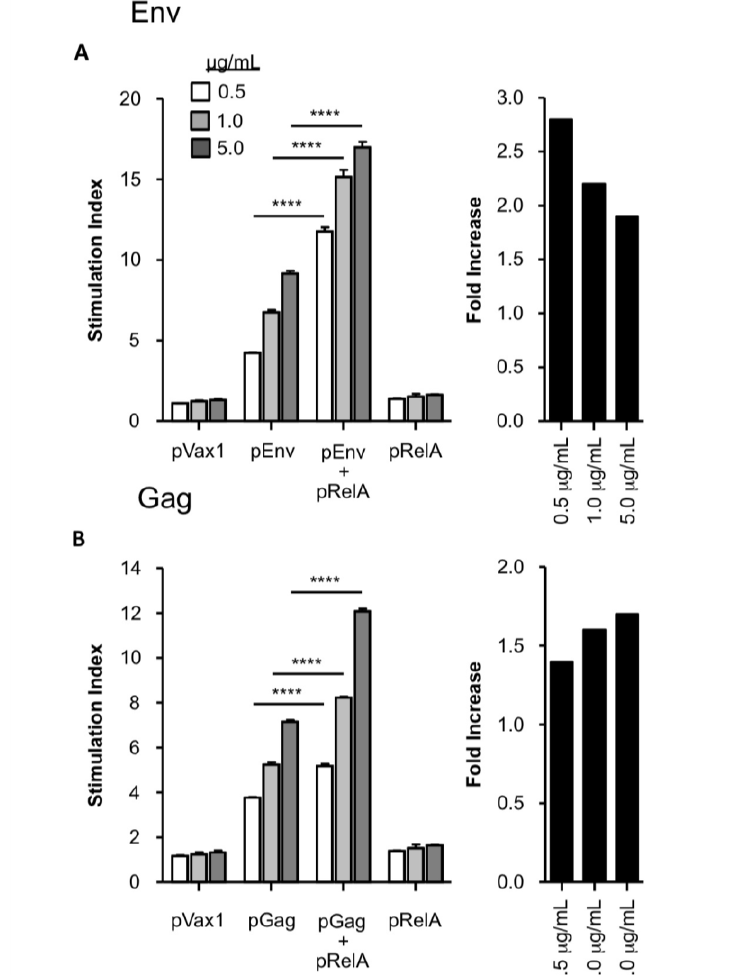
Figure 3. Increased T-cell proliferative potential following DNA vaccination plus co-administration of pRelA. Proliferative responses were measured seven days following the third vaccination with either pEnv or pGag alone, pEnv or pGag with pRelA molecular adjuvant, or empty vector control pVax1 alone. Splenocytes were incubated with recombinant HIV-1 Env ( A ) or Gag ( B ) at various concentrations: 0.5 (white bars), 1.0 (light gray bars), and 5.0 (dark gray bars) and subsequently pulsed with tritiated ( 3 H)-thymidine for 24 h. Incorporated thymidine was expressed as a stimulation index (SI) calculated by dividing the mean cpm (counts per minute) of Ag-stimulated wells by the mean cpm of non-stimulated wells. Fold increase in SI for pRelA-adjuvanted mice are displayed for each concentration of Env ( A , right panel) or Gag ( B , right panel). Samples were tested in triplicate. Error bars represent the SEM, and statistically significant values are provided for the indicated group comparison shown in the graphs. **** p <